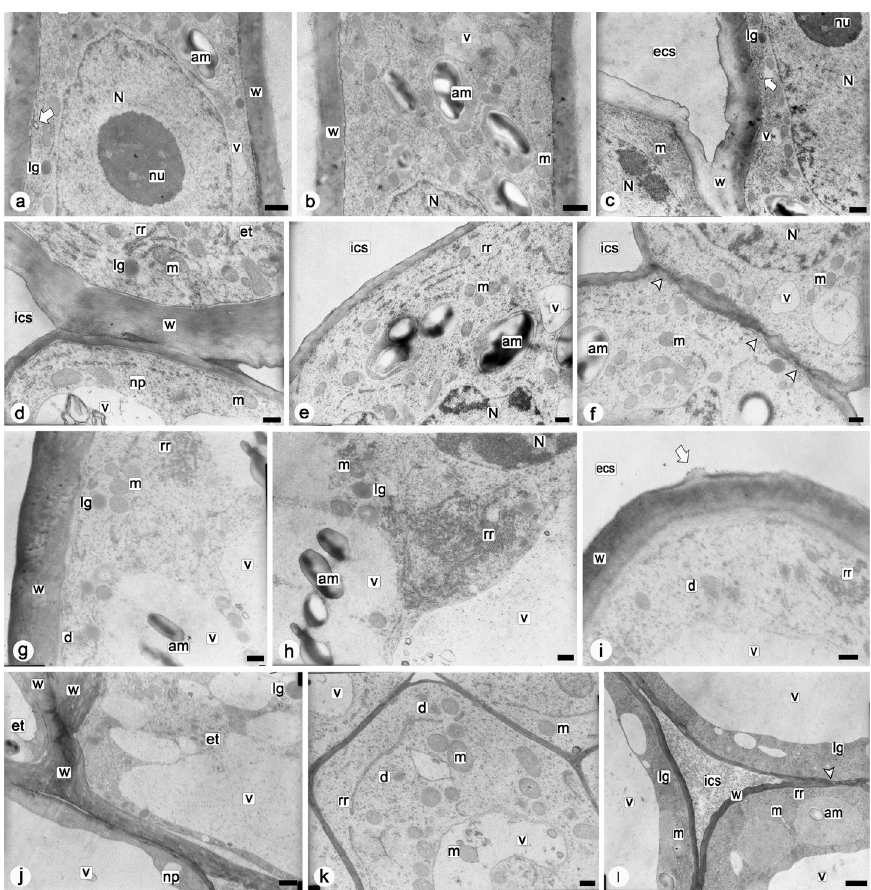
Figure 5. Transmission Electron Microscope (TEM) of floral nectary of E. terscheckii . a-f Pre-anthesis. ( a ) Proximal portion of an epidermal trichome, showing a large nucleus and a prominent nucleolus, white arrow indicates a small vacuole fusing with the cell membrane; note cell walls flared towards the base of the trichome. ( b ) Detail of dense granular cytoplasm of the trichome, note abundant mitochondria, vacuoles of small dimensions, abundant compound amyloplasts and few lipid globules. ( c ) Connection between two epidermal trichomes, showing portions of the nuclei of both cells, occupying a basal position; the white arrow indicates a vacuole fusing with the cell membrane. ( d ) Connection between epidermal trichome (upper position) and nectariferous parenchyma (lower position), observe cell walls of different thicknesses, and the absence of plasmodesmata between both cells. ( e ) Detail of dense cytoplasm of a parenchymal nectariferous cell, showing plastids with several grains of starch, small vacuoles, rough endoplasmic reticulum; note the intercellular space. ( f ) Detail of connection between two cells of the nectariferous parenchyma, white arrowheads indicate plasmodesmata that communicate the cytoplasm of secretory tissue cells. ( g-l ) Anthesis. ( g ) Portion of epidermal trichome, observe the cytoplasm less electrodense than in pre-anthesis, with larger vacuoles. ( h ) Detail of epidermal trichome cytoplasm, plastids with partially degraded starch grains; note the accumulation of rough endoplasmic reticulum in the cytoplasm. ( i ) Detail of the apical portion of the epidermal trichome with secretion released by rupture of the cuticle (white arrow). ( j ) Connection between two epidermal trichomes and an underlying nectariferous parenchyma cell; in both tissues, large vacuoles relegate the cytoplasm to the periphery of the cells. ( k ) Detail of nectariferous tissue cells, observe less dense cytoplasm and mitochondria in apparent degeneration. l Detail of intercellular space in the nectariferous tissue, with homogeneous electrodense material, suggests that sugary secretion accumulates in these spaces; note partially degraded amyloplasts, and plasmodesmata connecting cytoplasms (white arrowhead). Abbreviations : ( am ) amyloplast; ( d ) dictyosome; ( ecs ) extracellular space; ( ics ) intercellular space; ( lg ) lipid globule; ( m ) mitochondria; ( N ) nucleus; ( nu ) nucleolus; ( w ) cellular wall; ( np ) nectariferous parenchyma; ( rr ) rough endoplasmic reticulum; ( et ) epidermal trichome; (v) vacuole. Scale: a-c, j, l 1μm; d-i, k